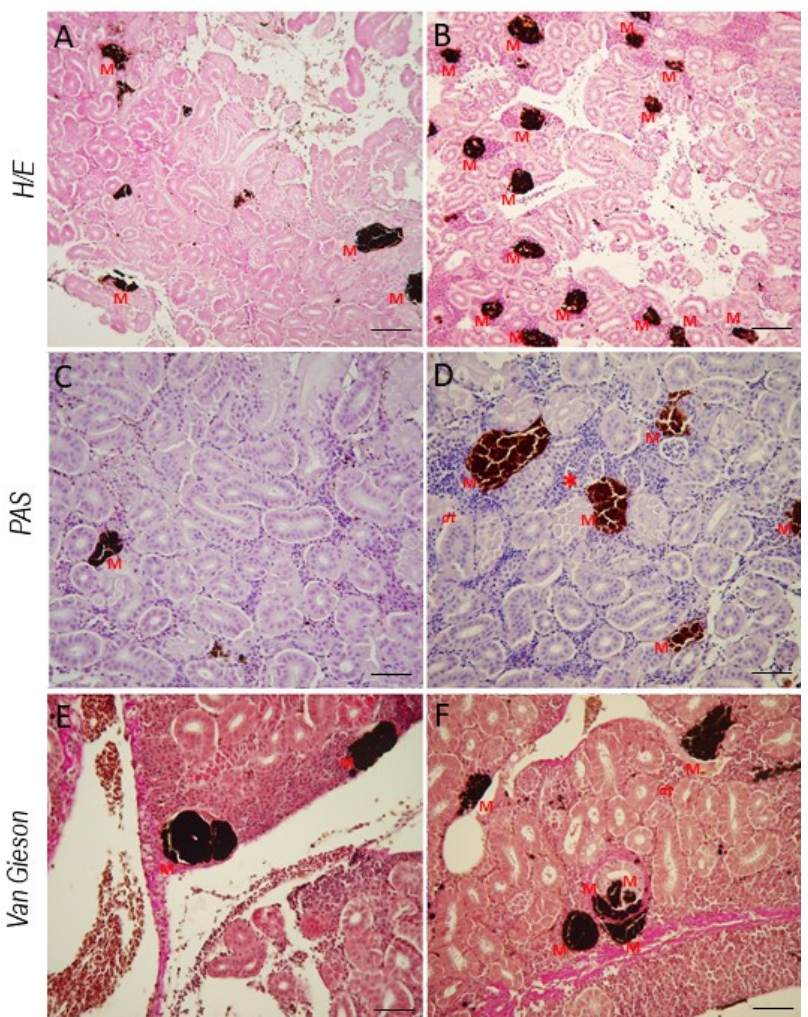
Figure 1. Boops boops kidney section. ( A , B ) H/E, 20×, scale bar 20 μ m. ( C , D ) PAS, 40×, scale bar 40 μ m. ( E , F ) Van Gieson, 40×, scale bar 40 μ m. In fish from the eastern coast of Milazzo, the renal parenchyma is slightly altered, glomeruli are congested and tubules are disorganized in places. An increase in MMCs can be noted. M = melanomacrophages centers; dt = disorganized tubules; * = congested glomeruli.